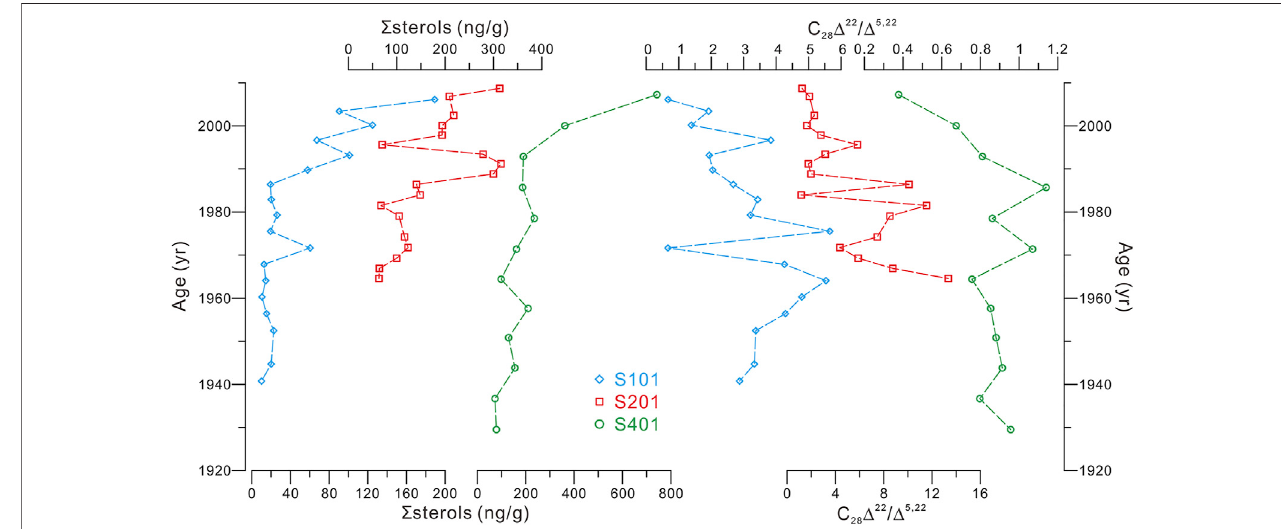
FIGURE 4 | Distribution of the (cid:4) sterols abundances and the C 28 Δ 22 / Δ 5,22 ratios in the three cores.